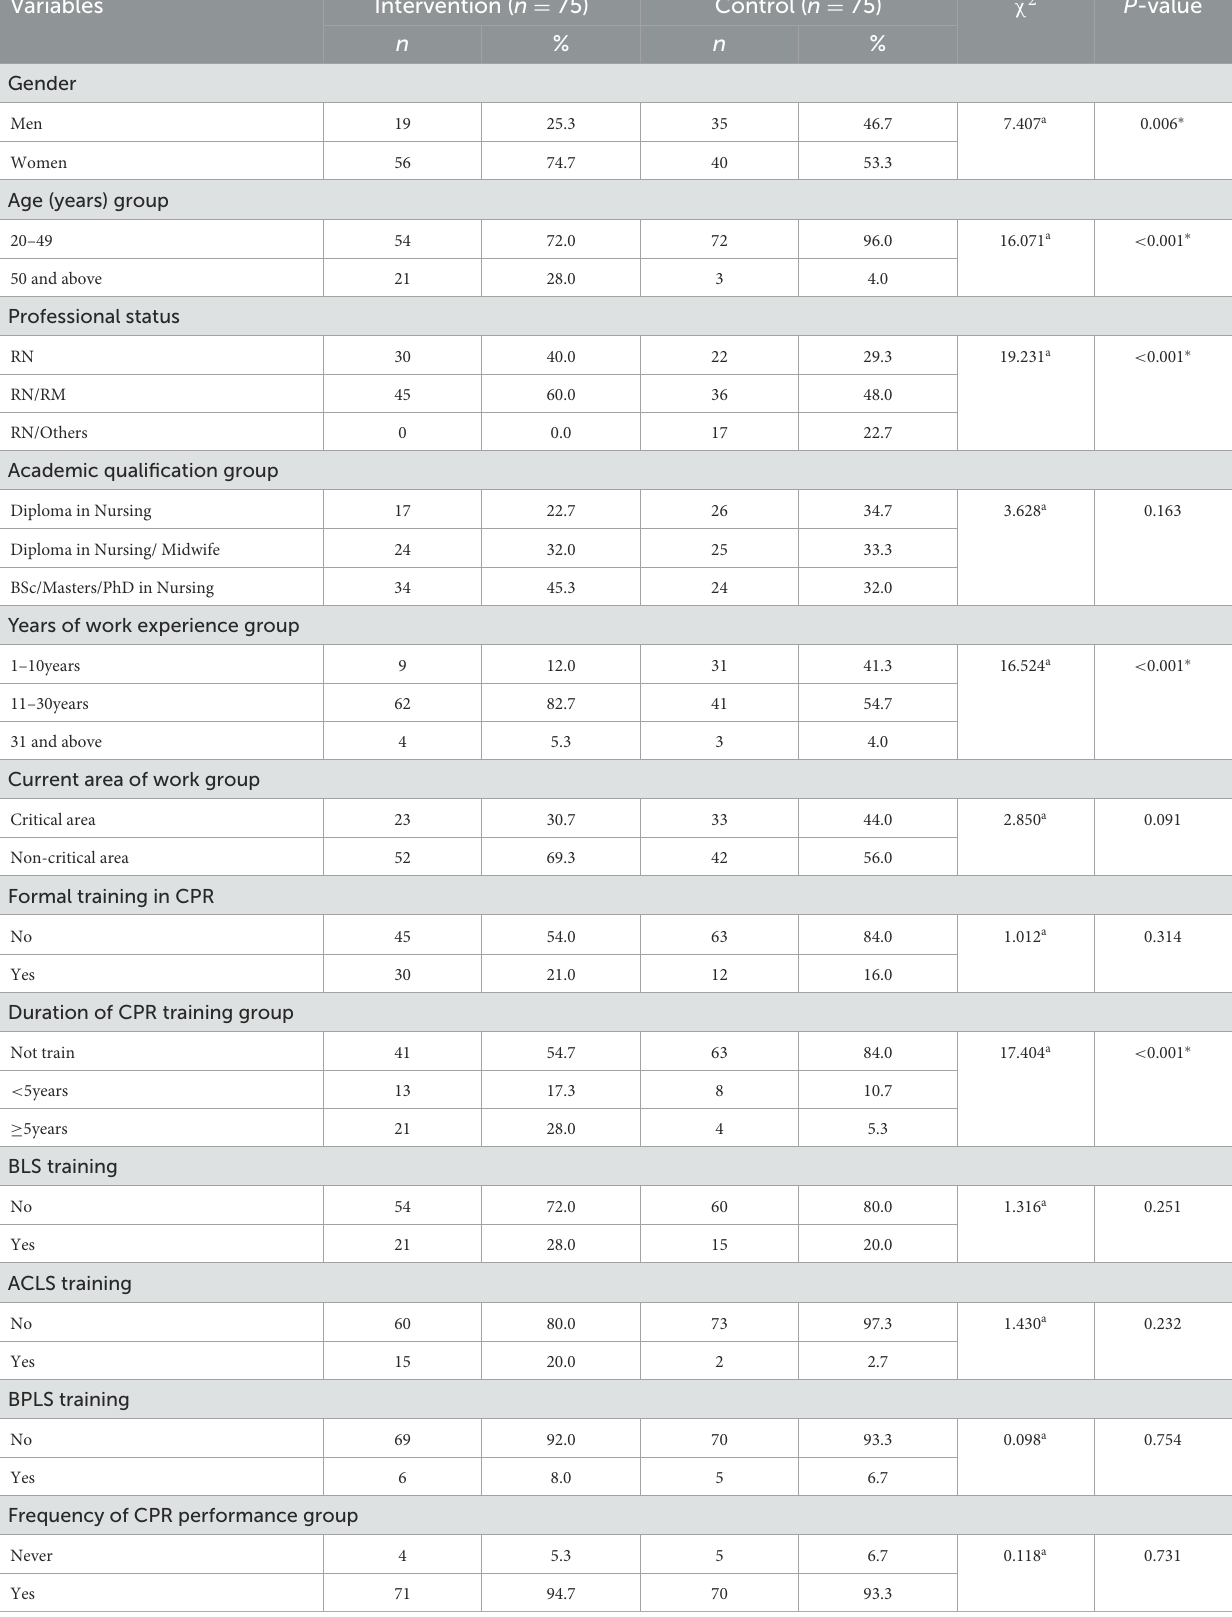
TABLE 1 Baseline comparison of sociodemographic and work-related factors between the intervention and control groups ( N = 150). Variables Intervention ( n =